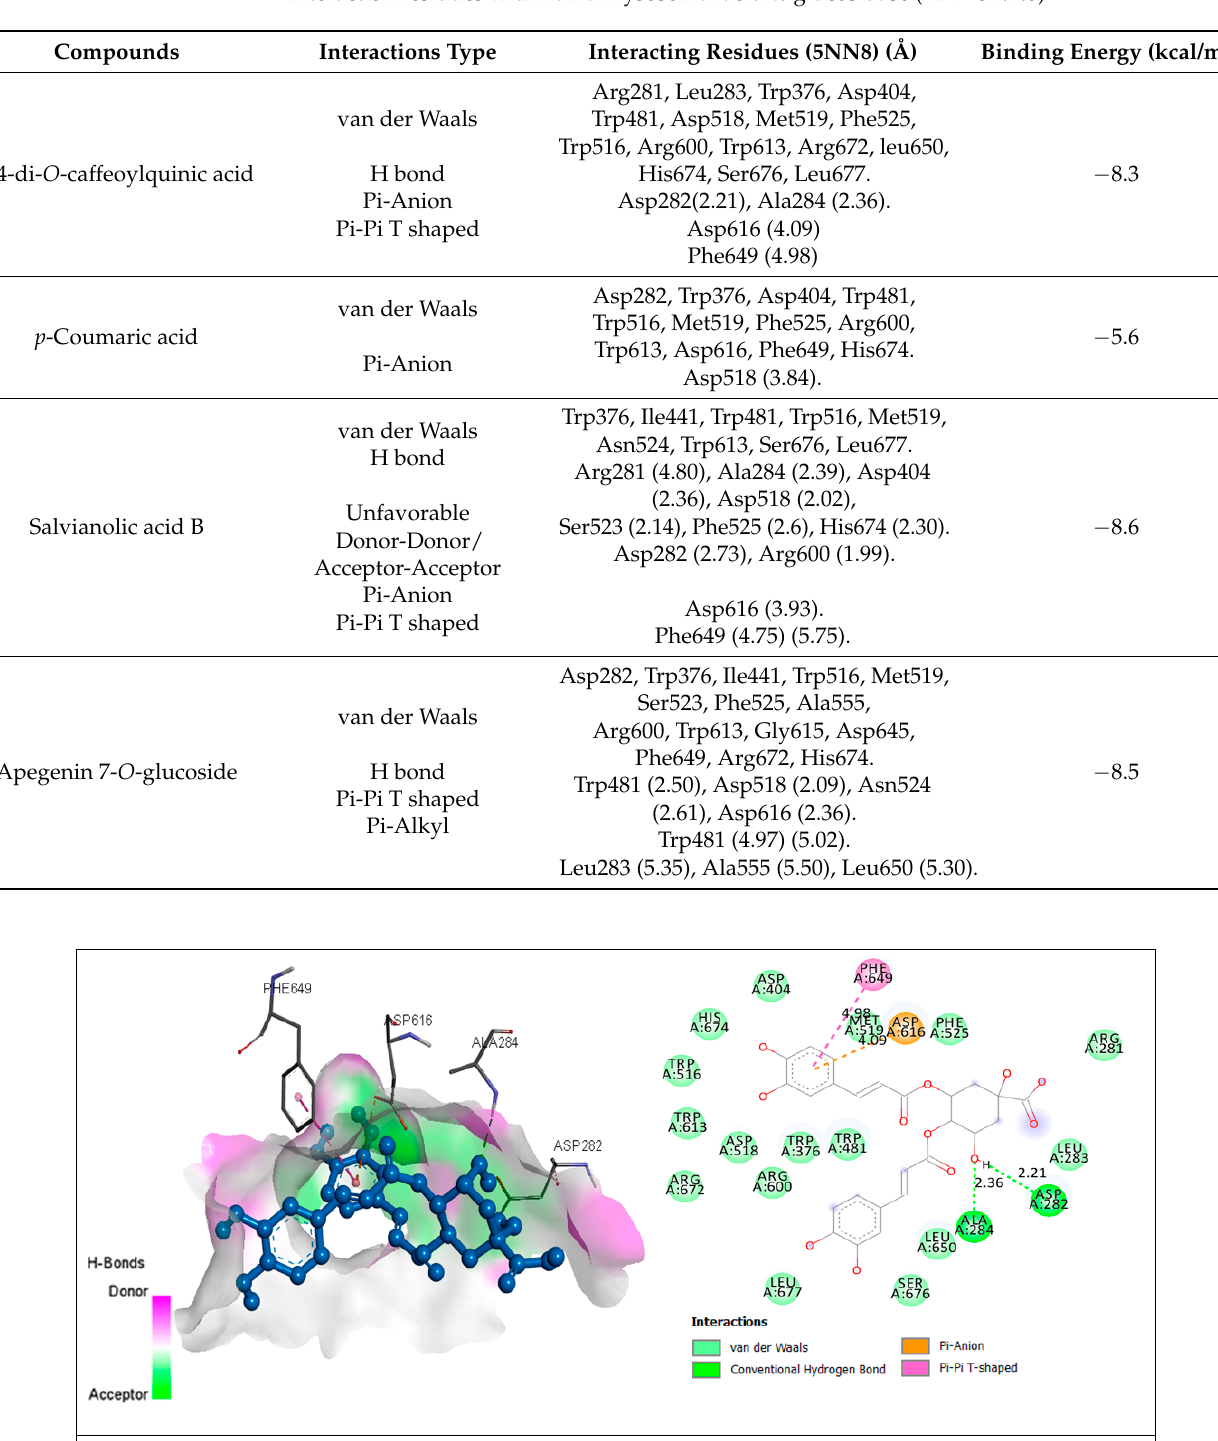
Table 6. Major phytochemicals, with the top two having the lowest binding energies with their interaction residues with human lysosomal acid- α -glucosidase (PDB: 5NN8).